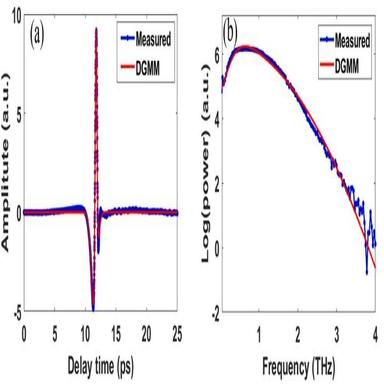
The fitted results of the DGMM for the measured THz reference signal. (a) The fitted result of the time-domain THz signal; (b) The fitted result of the frequency-domain THz signal.